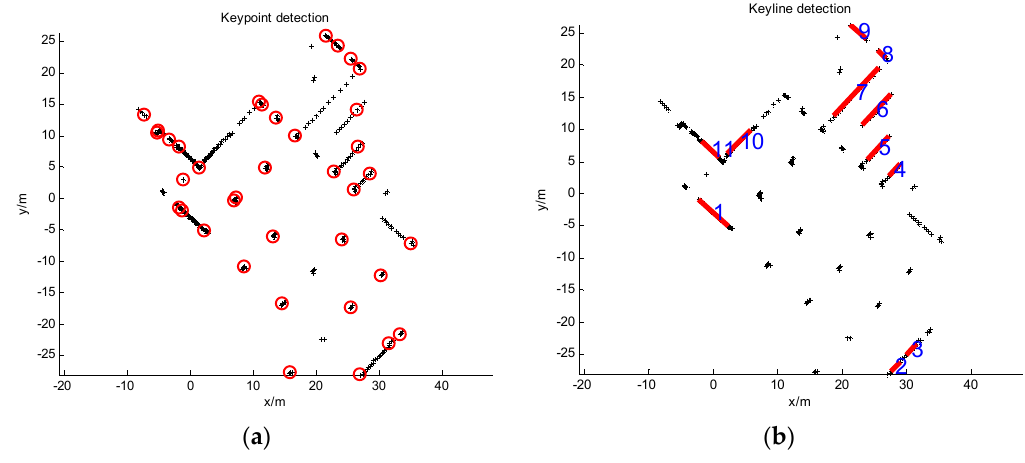
Figure 1. Point and line features detected from a laser scan. ( a ) feature point detection; ( b ) feature line detection.